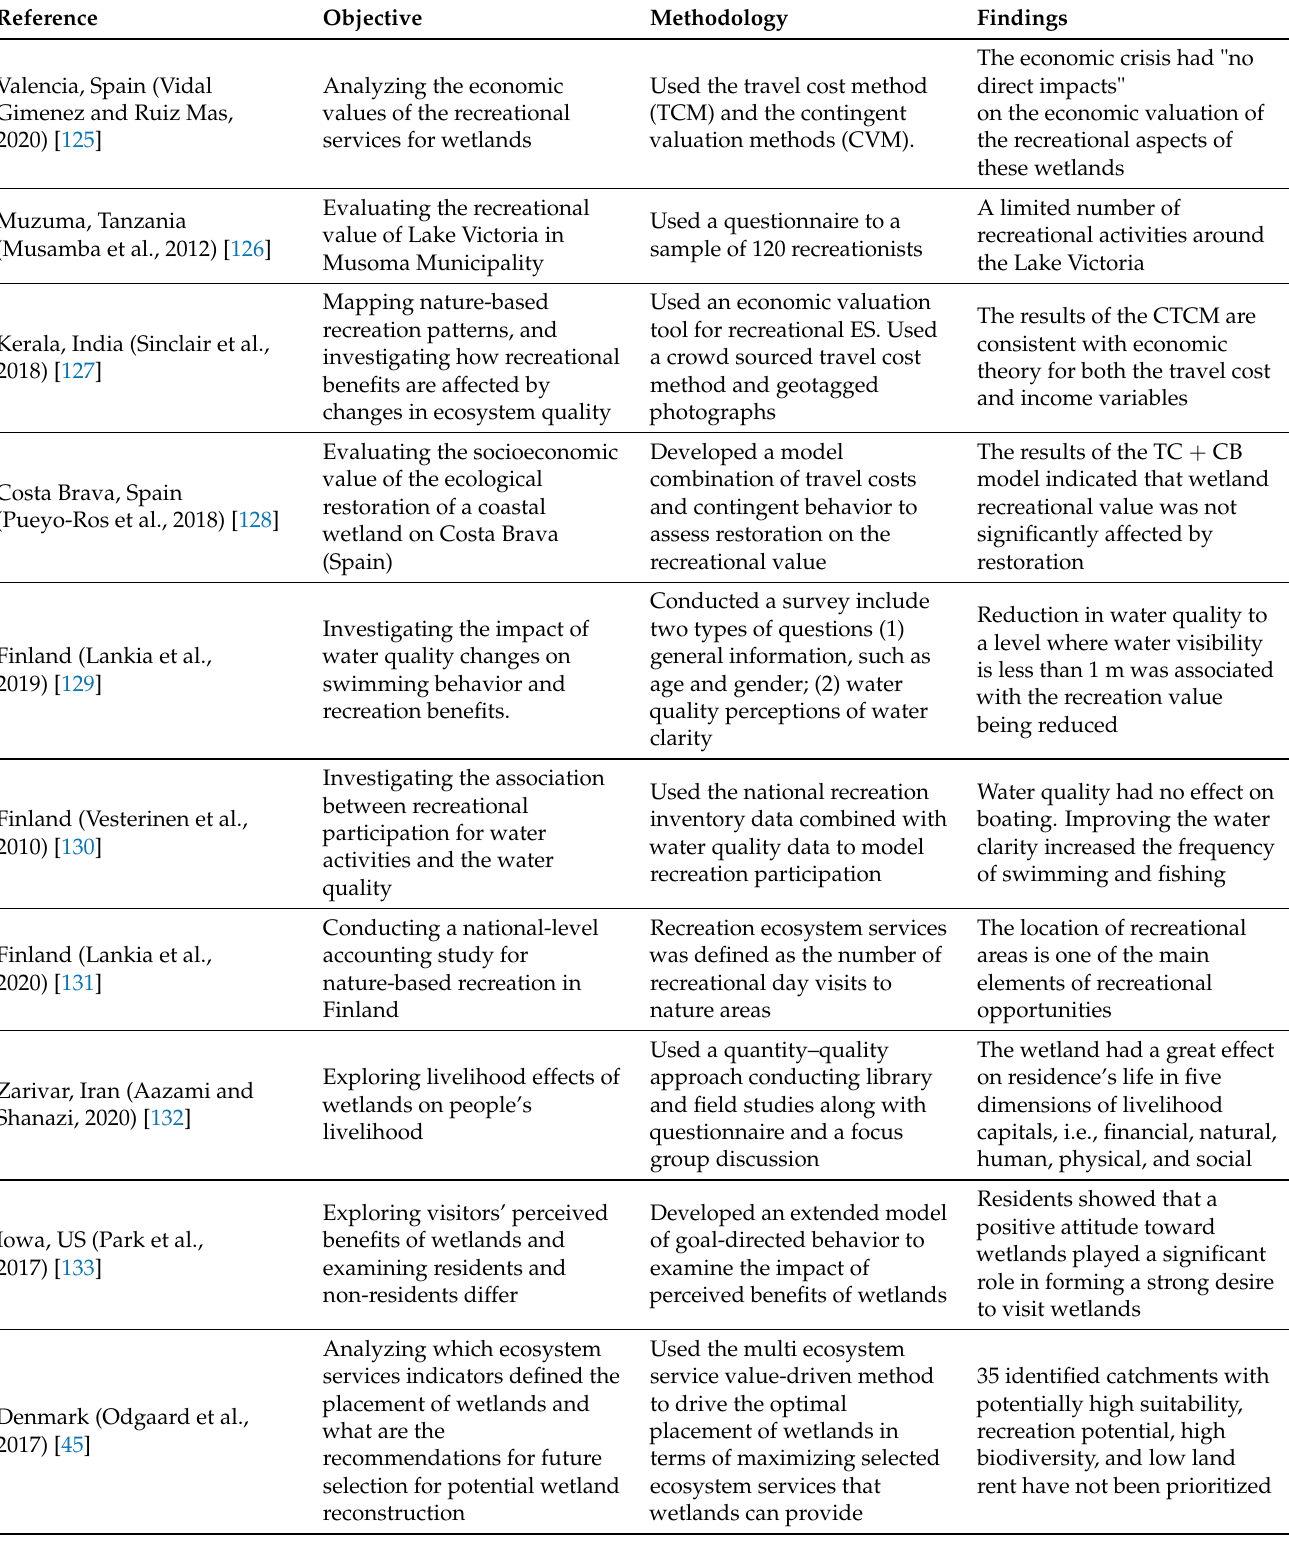
Table 5. Urban wetlands and recreational